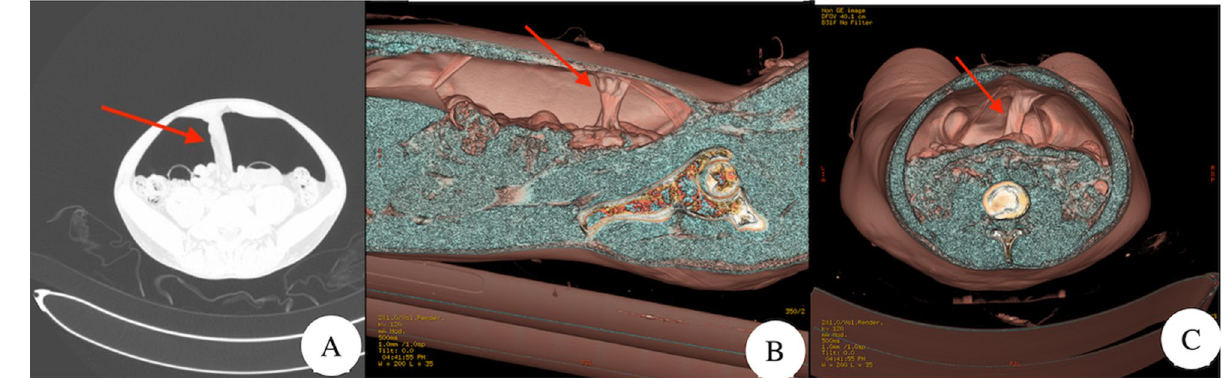
Figure 3. Image reconstruction, ( B ) and ( C ) are reconstructed on the basis of ( A ), the arrow shows the adhesions of intestine and abdominal